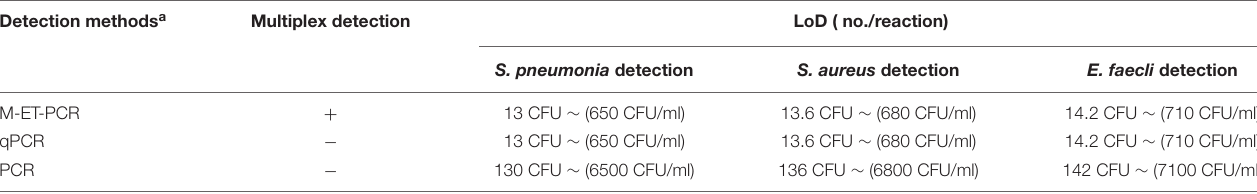
TABLE 4 | Comparison of ET-PCR, qPCR (SYBR) and PCR assays for detection of S. pneumonia , S. aureus, and E. faeclis in artificially contaminated blood samples. Detection methods a Multiplex